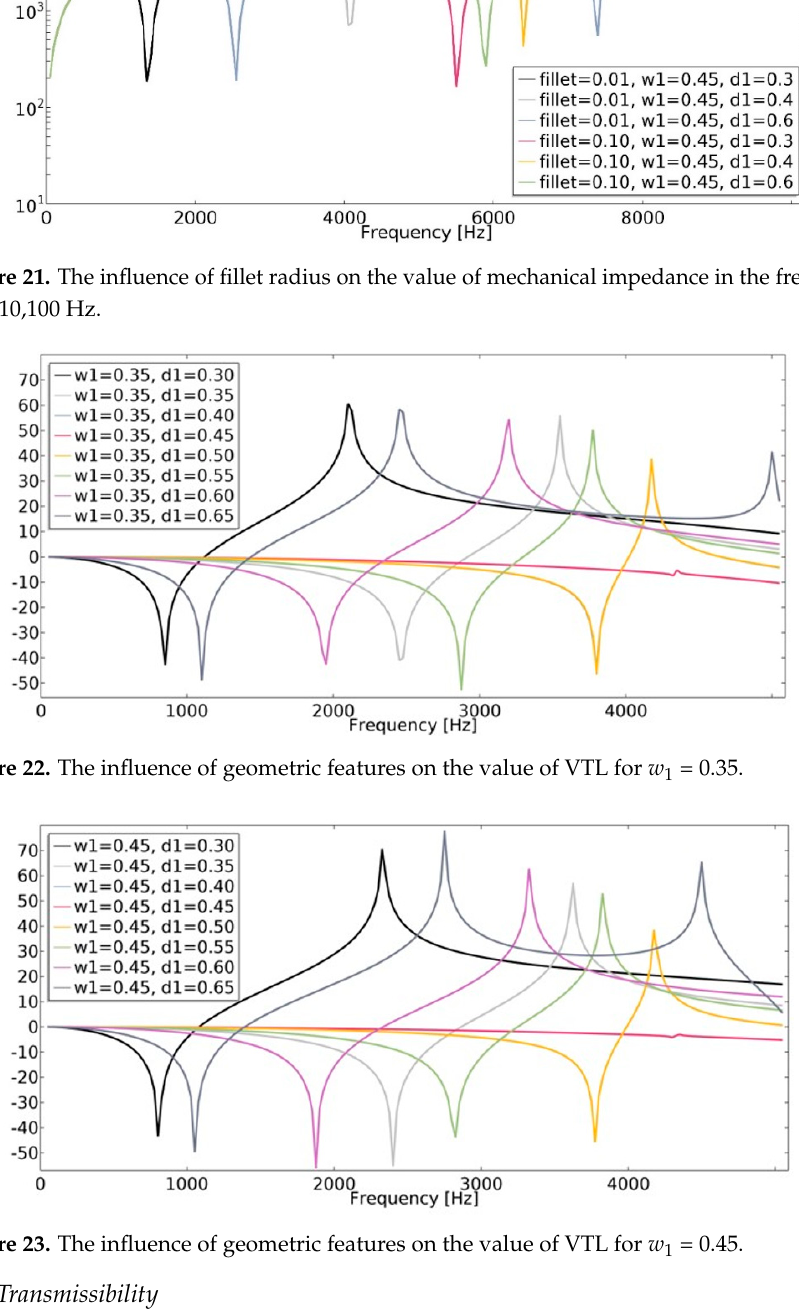
Figure 21. The influence of fillet radius on the value of mechanical impedance in the frequency range of 1–10,100 Hz.